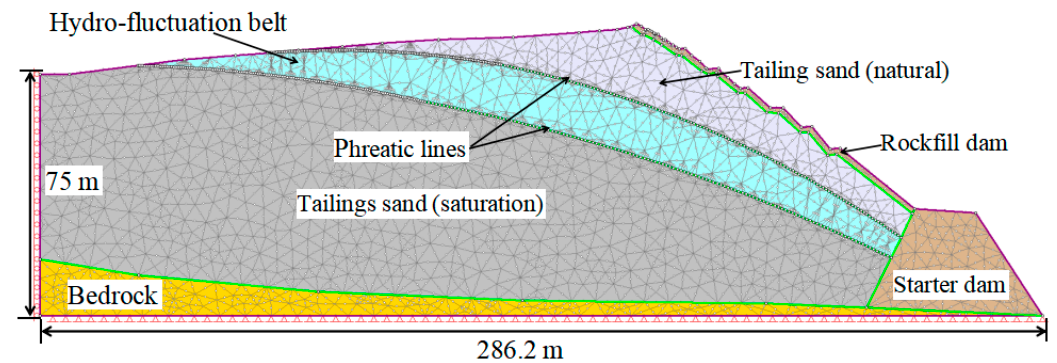
Figure 5. Numerical calculation model. Table 2. Calculation parameters for the numerical model.